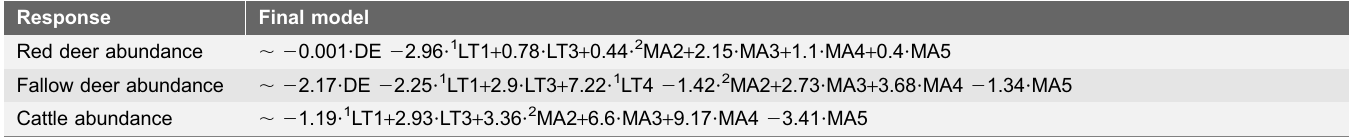
Table 2. Results of the generalised linear models (negative binomial error distribution and logarithmic link function) used to predict red deer, fallow deer and cattle abundance on a spatial scale in Don˜ana National